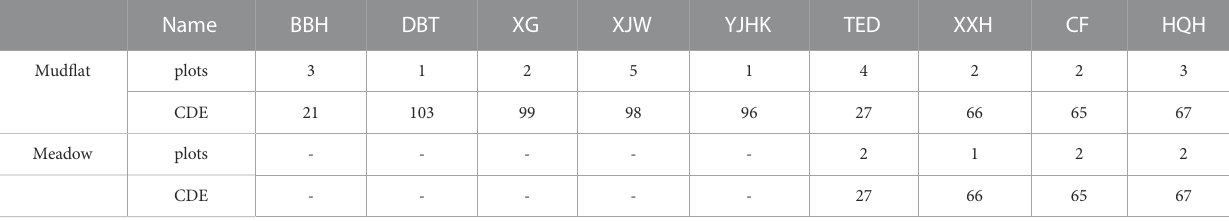
TABLE 1 The replications description and the cumulated days of exposure (CDE)of sampling